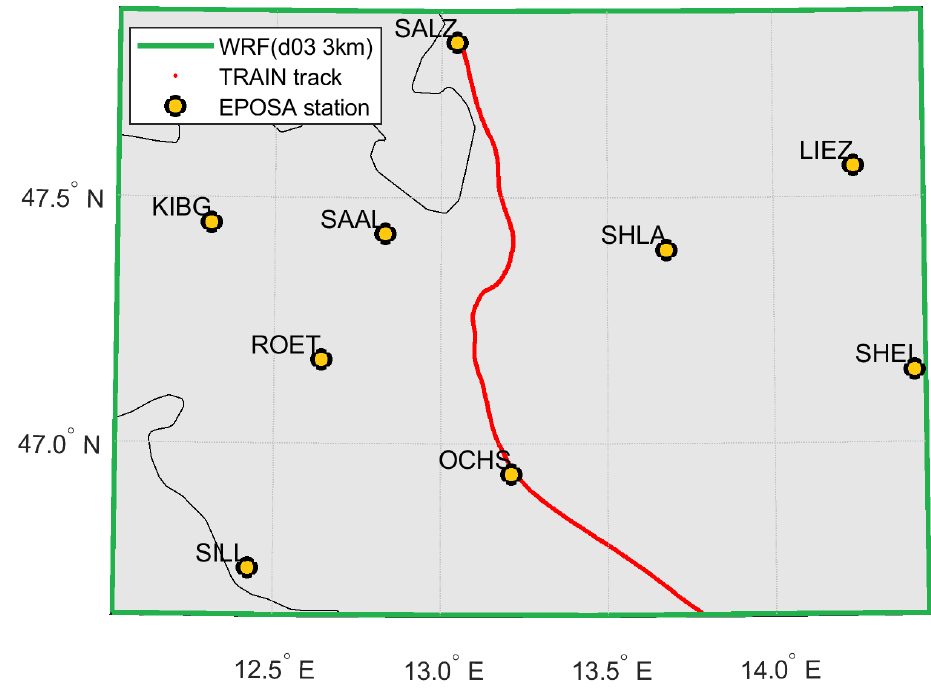
Figure 7. WRF model domain (green) with the covered train track (red) and nearby EPOSA stations utilized for comparison (orange dots).